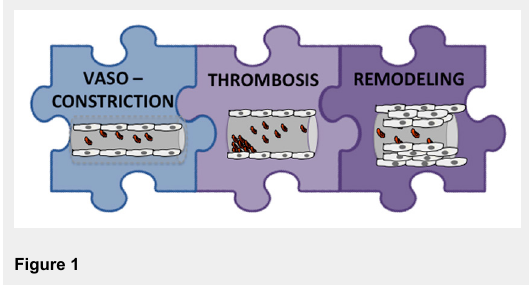
The three pieces in the pathogenesis of pulmonary hypertension. Pure vasoconstriction occurs in early disease; microthrombotic events are observed at increasing frequency during evolution of the disease; remodelling of the small pulmonary arteries is arguably the most important